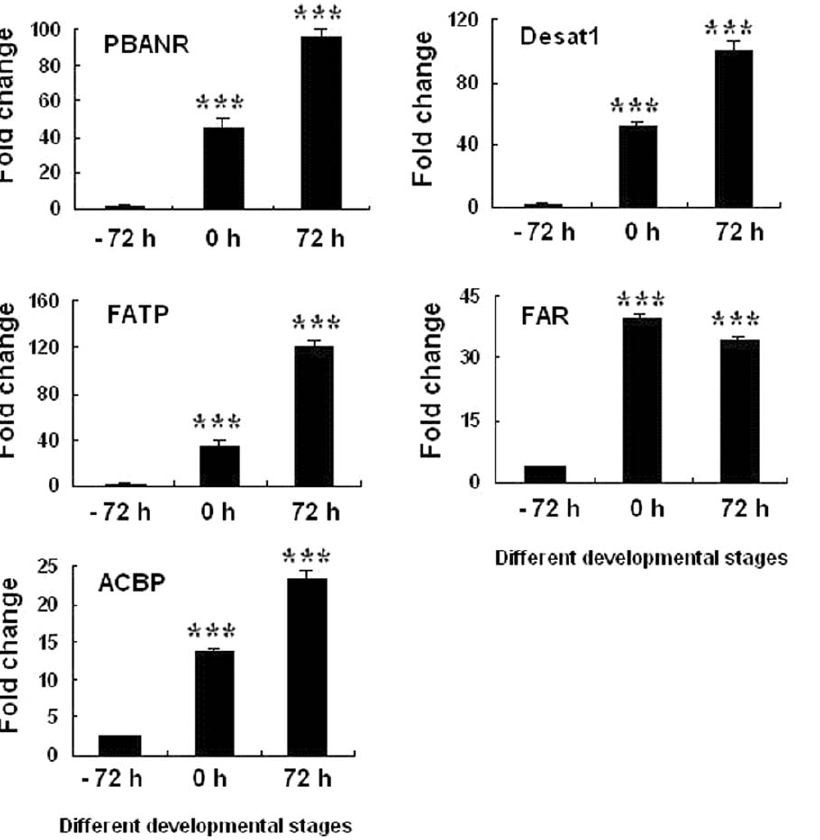
Figure 5. Temporal changes in relative expression levels of genes associated with pheromone synthesis in the PG of B.mori during pupal–adult development (the zero time point indicates the time of eclosion). PGs were collected at different developmental stages ( 2 72, 0, and 72 h), and total RNA was extracted for real-time PCR analysis. The Rp49 gene was used as the housekeeping gene for normalization. The data represent the mean values 6 SE of three biological replicates. Significance of pairwise comparisons ( 2 72 h vs 0 h and 2 72 h vs 72 h) are marked with *** (p , 0.001) as determined by the Student’s t -test .